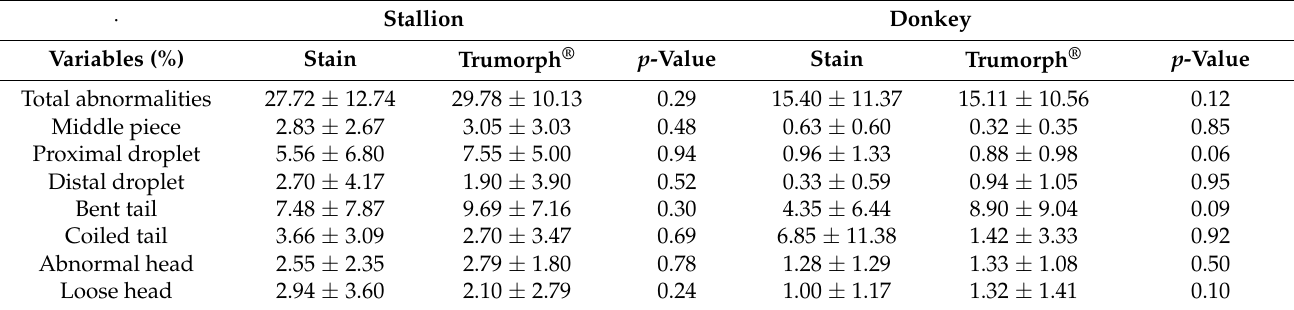
Table 1. Morphological abnormalities of sperm in relation to the technique used (means ±